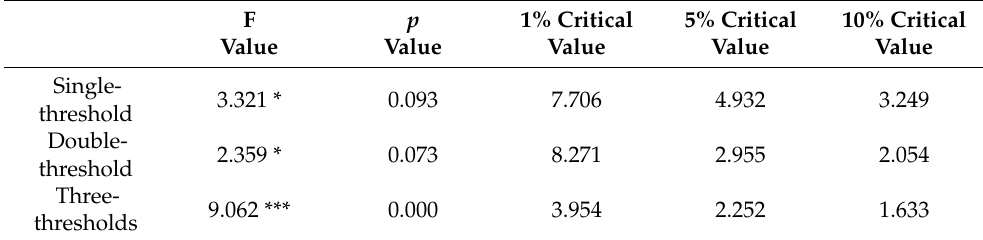
Table 3. Threshold effect test: From the perspective of green innovation factor